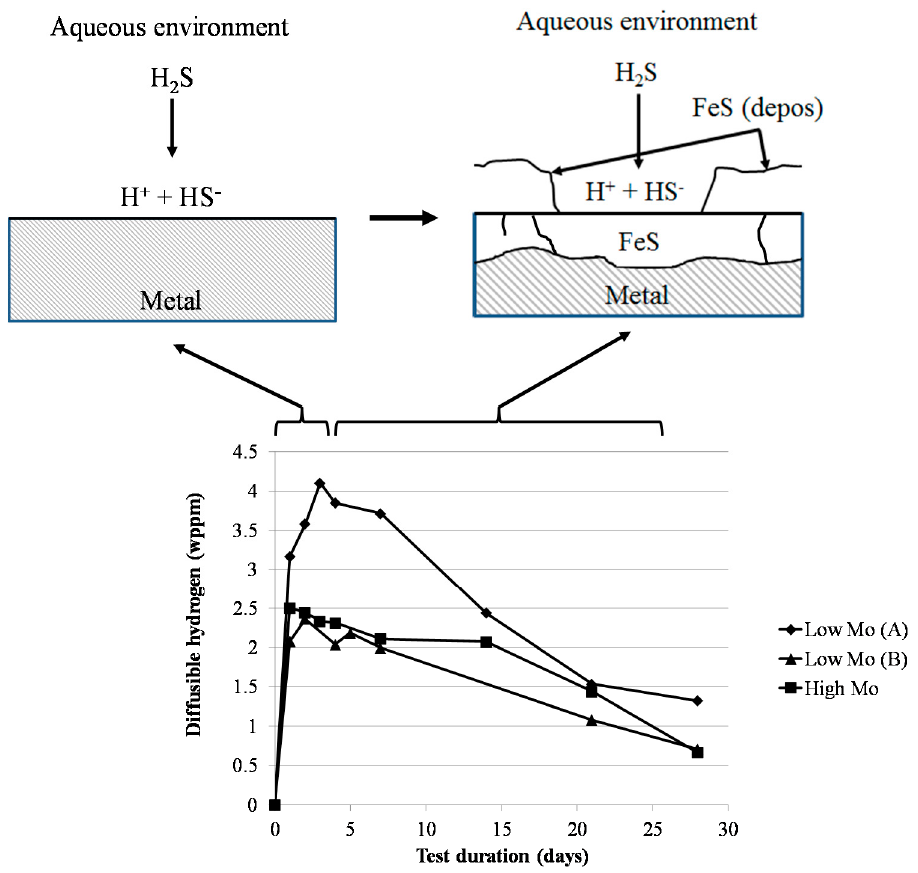
Figure 11. Schematic overview of the corrosion product formation and the influence of this corrosion product on the hydrogen content inside the metal.